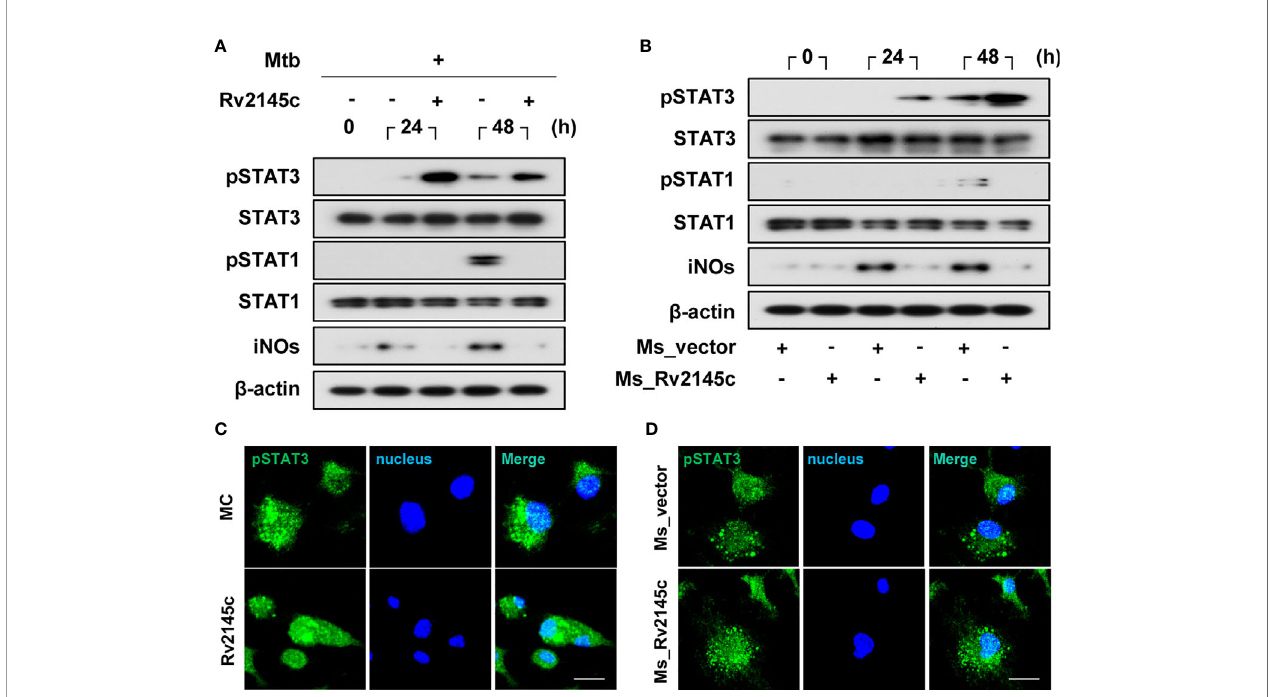
FIGURE 5 | Rv2145c induces activation of STAT3 in Mtb-infected macrophages. (A, B) BMDMs were infected with (A) Mtb at an MOI of 1 for 4 h and incubated with or without 10 m g/ml Rv2145c or (B) Ms_vector or Ms_Rv2145c at an MOI of 10 for 4 h. The cells were lysed at the indicated times, and the proteins in the total cell lysate were separated by SDS – PAGE, followed by immunoblot analysis using antibodies against phospho-STAT3, STAT3, phospho-STAT1, STAT1, iNOs and b - actin. This image is representative of three experiments showing similar results. (C, D) At 48 h after Mtb infection (C) or at 24 h after M. smegmatis infection (D) , BMDMs were fi xed with 4% paraformaldehyde and immunolabeled with an anti-phospho-STAT3 antibody, followed by Alexa 488-conjugated goat anti-rabbit IgG. The cells were stained with DAPI to visualize the nuclei (blue). The localization of the target molecules was analyzed by laser-scanning confocal microscopy. Scale bar, 10 m m. MC, medium